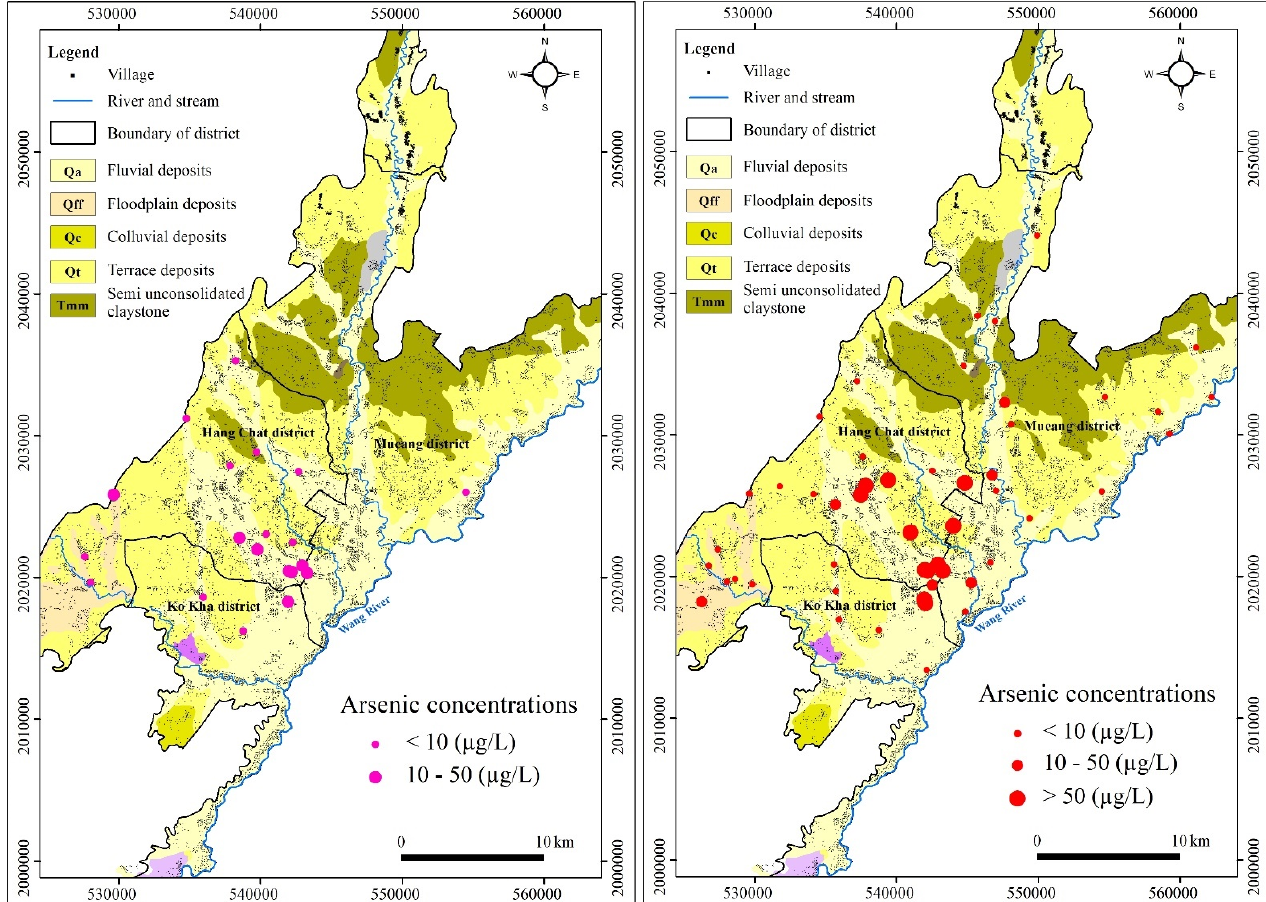
Figure 8. Arsenic content in shallow ( left ) and deep wells ( right ) in dry season.